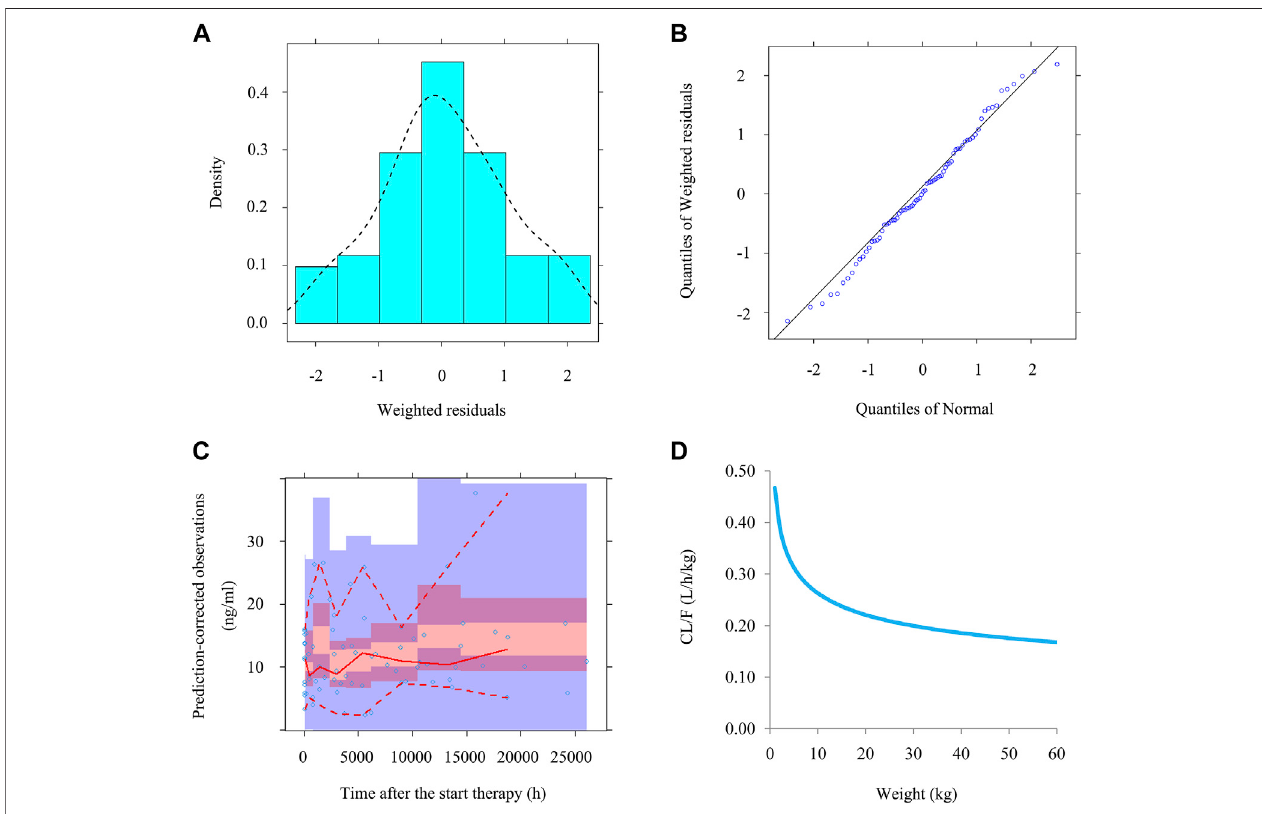
FIGURE 2 | The evaluation of normality and VPC. (A) Density vs. weighted residuals. (B) Quantilies of weighted residuals vs. quantilies of normal. (C) Prediction- corrected visual predictive check (VPC) of model. The middle solid line represents the median of the prediction-corrected concentrations. The lower and upper dashed lines are the 2.5 and 97.5th percentiles of the prediction-corrected concentrations. (D) Sirolimus apparent clearance rate of pediatric patients with different weight.